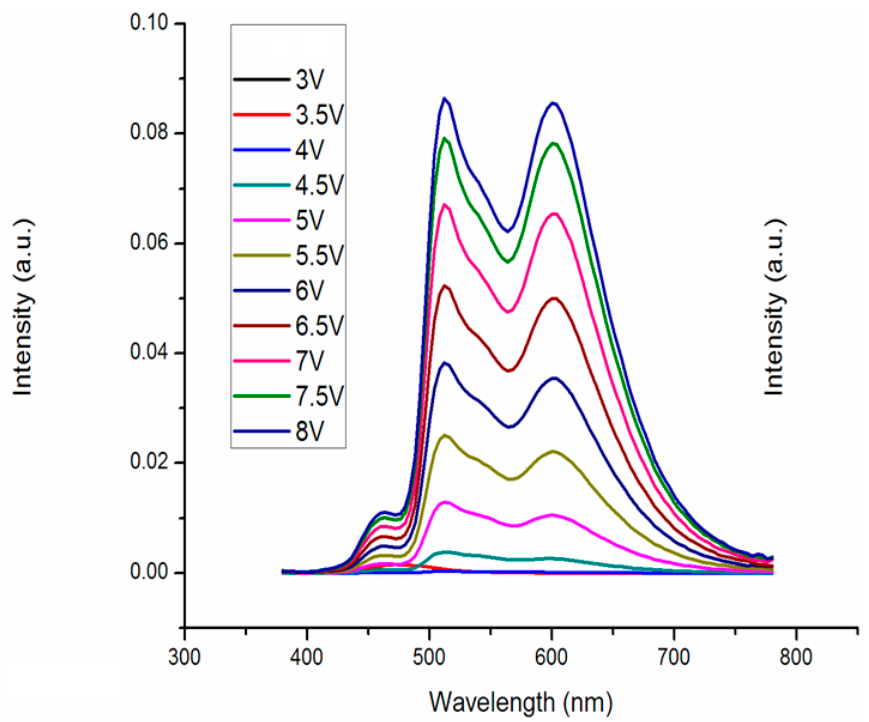
Figure 2. Spectrum of the RGB-stacked WOLED.